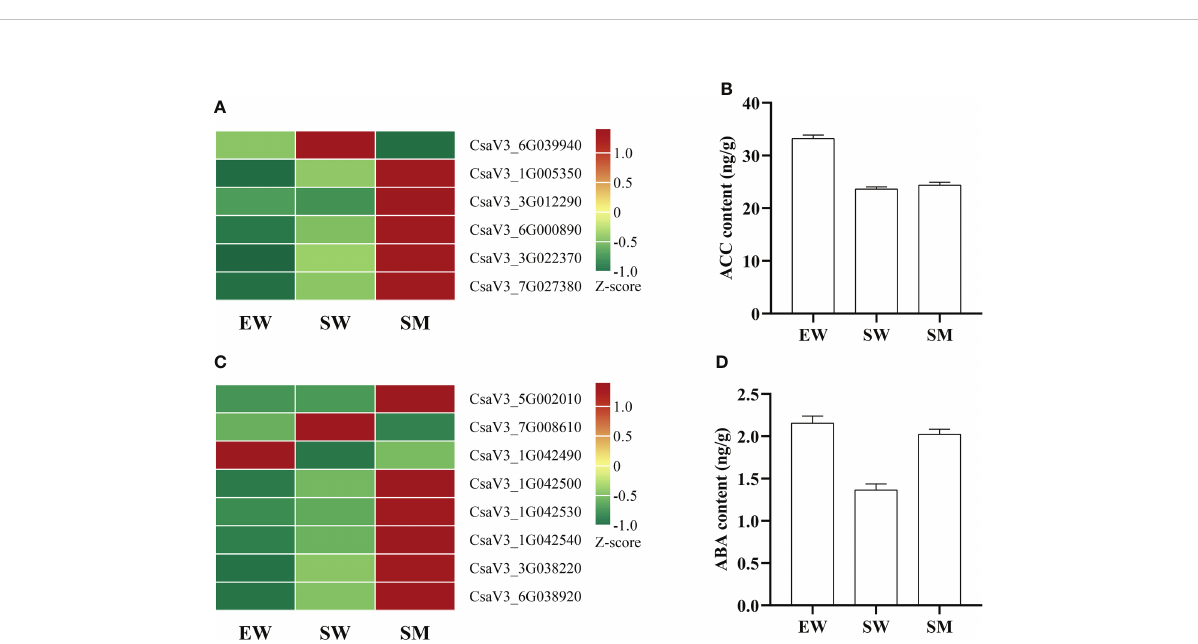
FIGURE 6 Effects of melatonin on genes and hormones related to ethylene and abscisic acid in cucumber seedings. (A, B) Effects of melatonin on the expression of ethylene-related genes and ethylene content. (C, D) Effects of melatonin on the expression of abscisic acid-related genes and abscisic acid content. EW (hypocotyl exposed and irrigated with water), SW (hypocotyl shaded and irrigated with water) and SM (hypocotyl shaded and irrigated with 100 µM